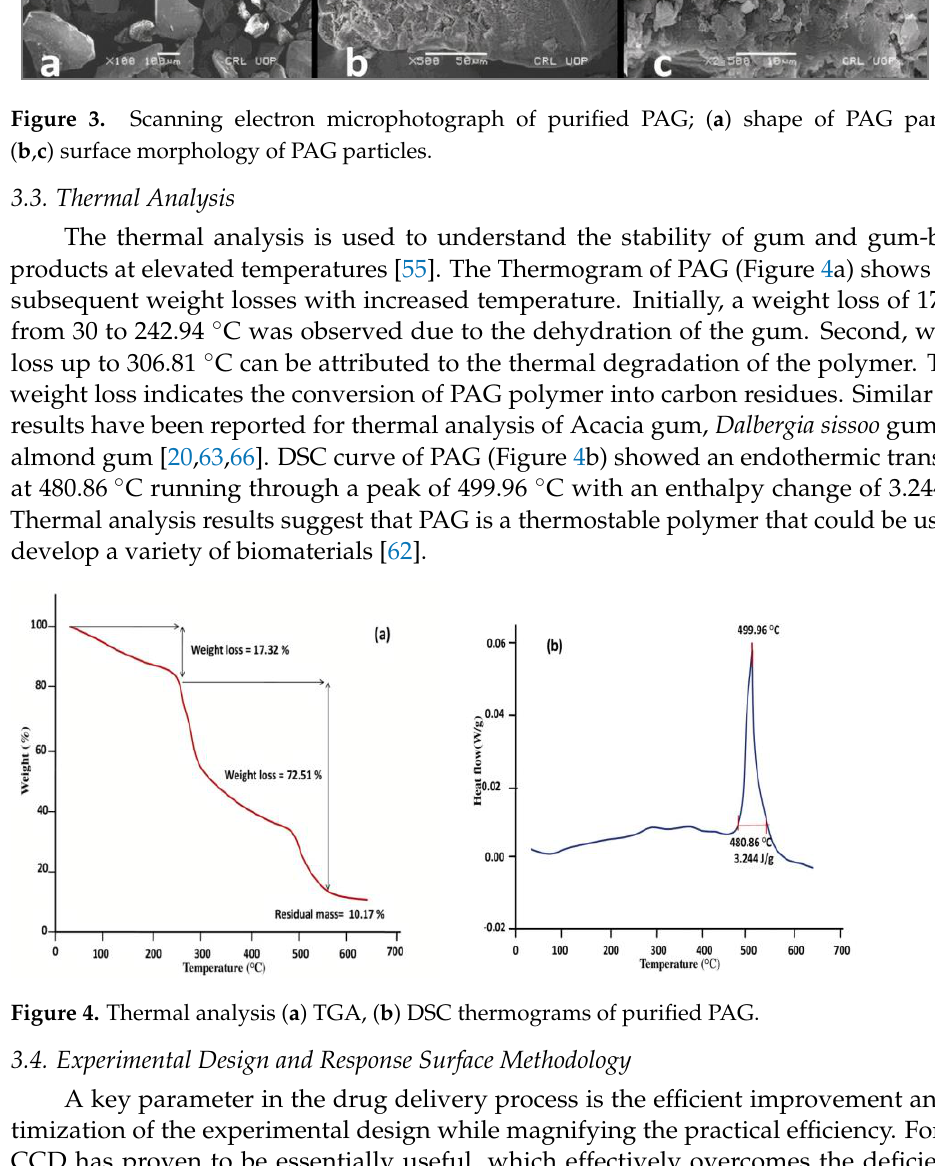
Figure 3. Scanning electron microphotograph of purified PAG; ( a ) shape of PAG particles; ( b , c ) surface morphology of PAG particles.